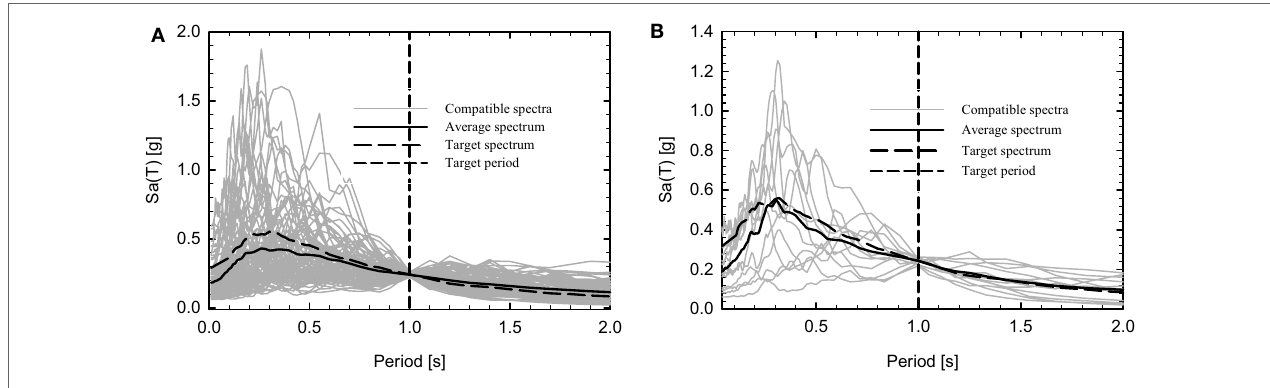
FigUre 10 | Single period matching with conditional mean spectrum as target spectrum, for the (a) Peer database and (B) esMD .